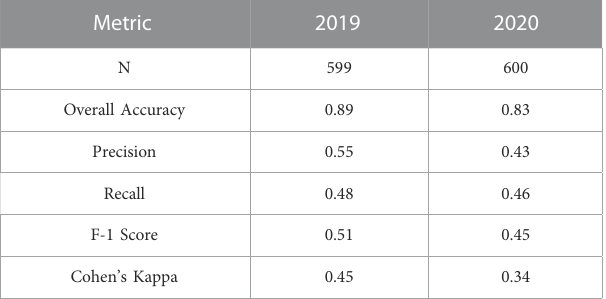
TABLE 3 Independent Validation reported metrics for 2019 and 2020 LTE2 555 model